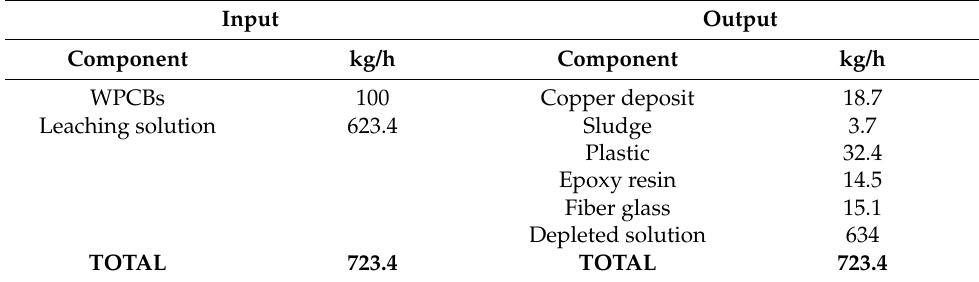
Table 10. Overall mass balance of the scaled-up dismantling process.